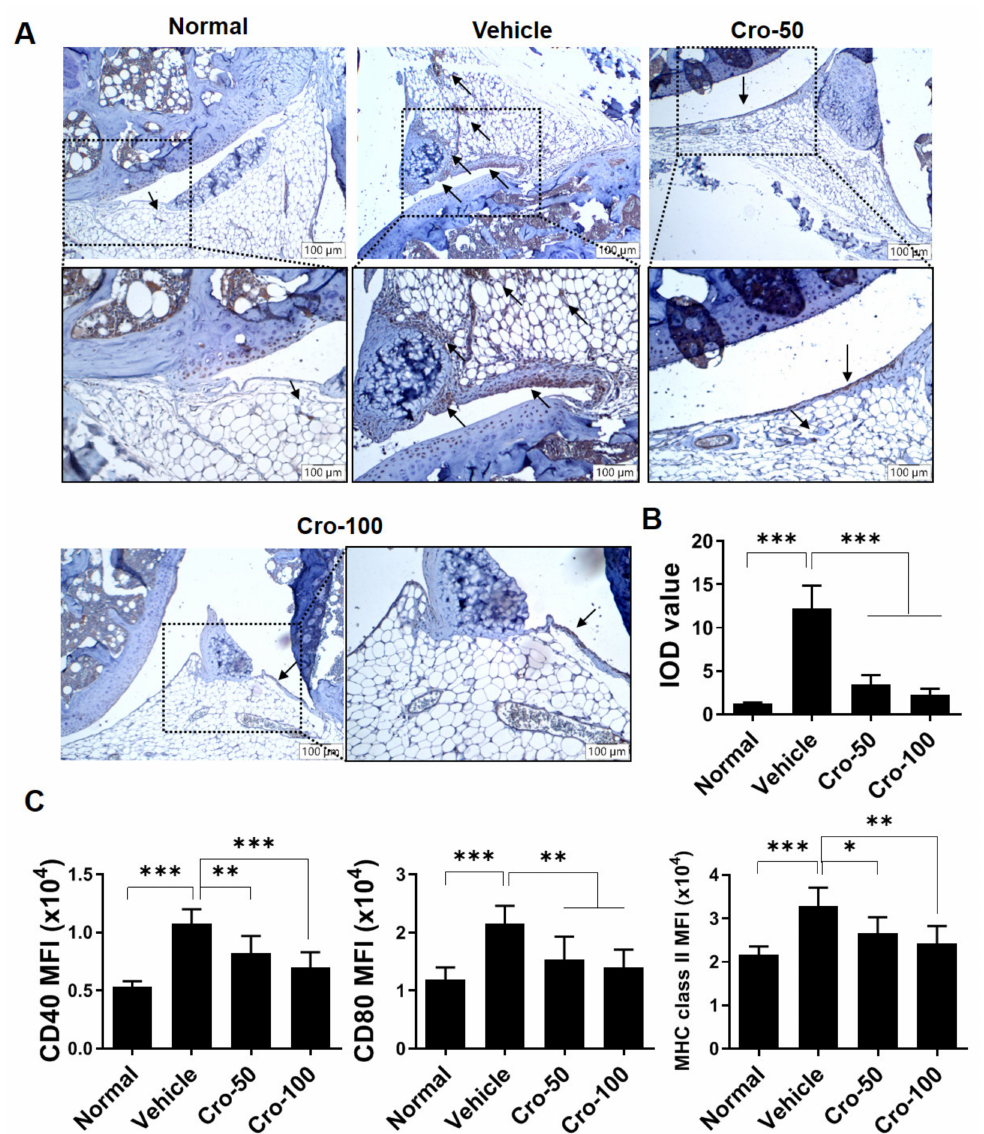
Figure 3. Infiltration or activation of either synovial or splenic CD11c + cells were suppressed by crotonoside. ( A ) Detection of CD11c expressing cells (brown, indicated by arrows) by immunohistochemical analysis in the knee joint tissues. ( B ) The integrated optical density (IOD) values of CD11c + cells in synovial membrane tissues were qualified and compared among the groups. ( C ) Mean fluorescence intensity (MFI) of CD40, CD80, and MHC class II expression was determined by gating CD11c + DCs in normal and CIA mice with or without crotonoside treatments at indicated concentrations. Data ( n = 6 per group) are from one of three experiments and expressed as the mean ± SD. * p < 0.05, ** p < 0.01, *** p < 0.001, versus CIA vehicle groups, as determined by a one-way ANOVA with Dunnett